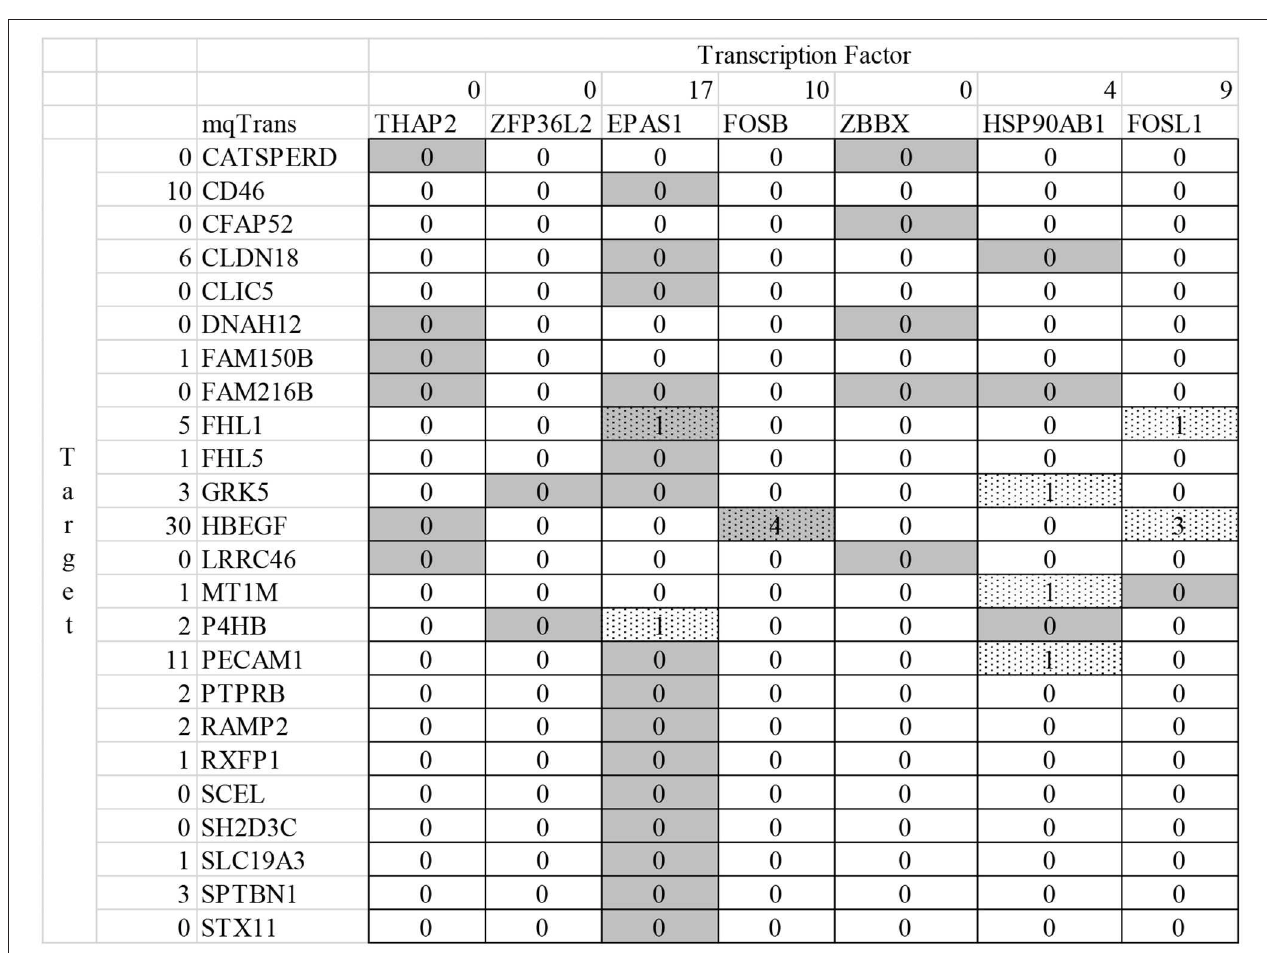
FIGURE 5 | Summary of the literature support for the detected transcriptional regulatory relationships altered in lung cancers. The heatmap with the solid boundary lines illustrate the transcriptional regulatory relationships altered in lung cancers. Each row is a target mRNA, which is transcriptionally regulated by the transcription factors denoted by the gray boxes in that row. The dotted box suggests that the transcription factor in that column and the target mRNA in that row are investigated in the same PubMed literature (Canese and Weis, 2013), and the number in that box is the number of publications mentioned both the transcription factor and the target mRNA. The number in the column left to the target mRNA gene symbols is the number of publications investigating the gene symbol of the target mRNA in lung cancers. And the number in the second row is the number of publications investigating the TF gene under the